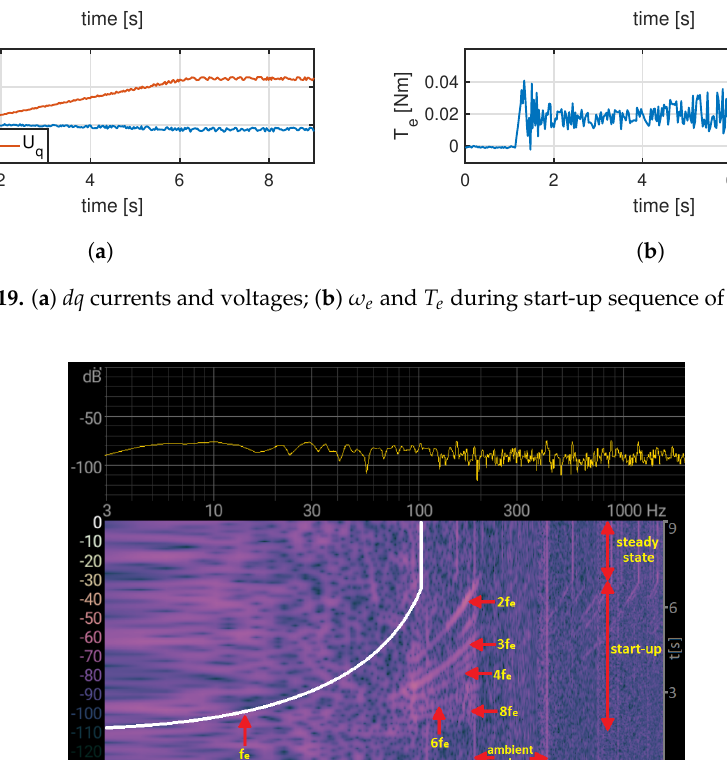
). Cogging torque map s and no-load condition. s